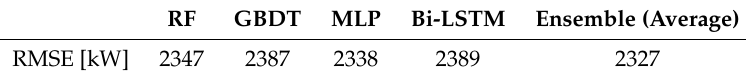
Table 3. Forecasting performance in terms of Root Mean Square Error (RMSE), for the five